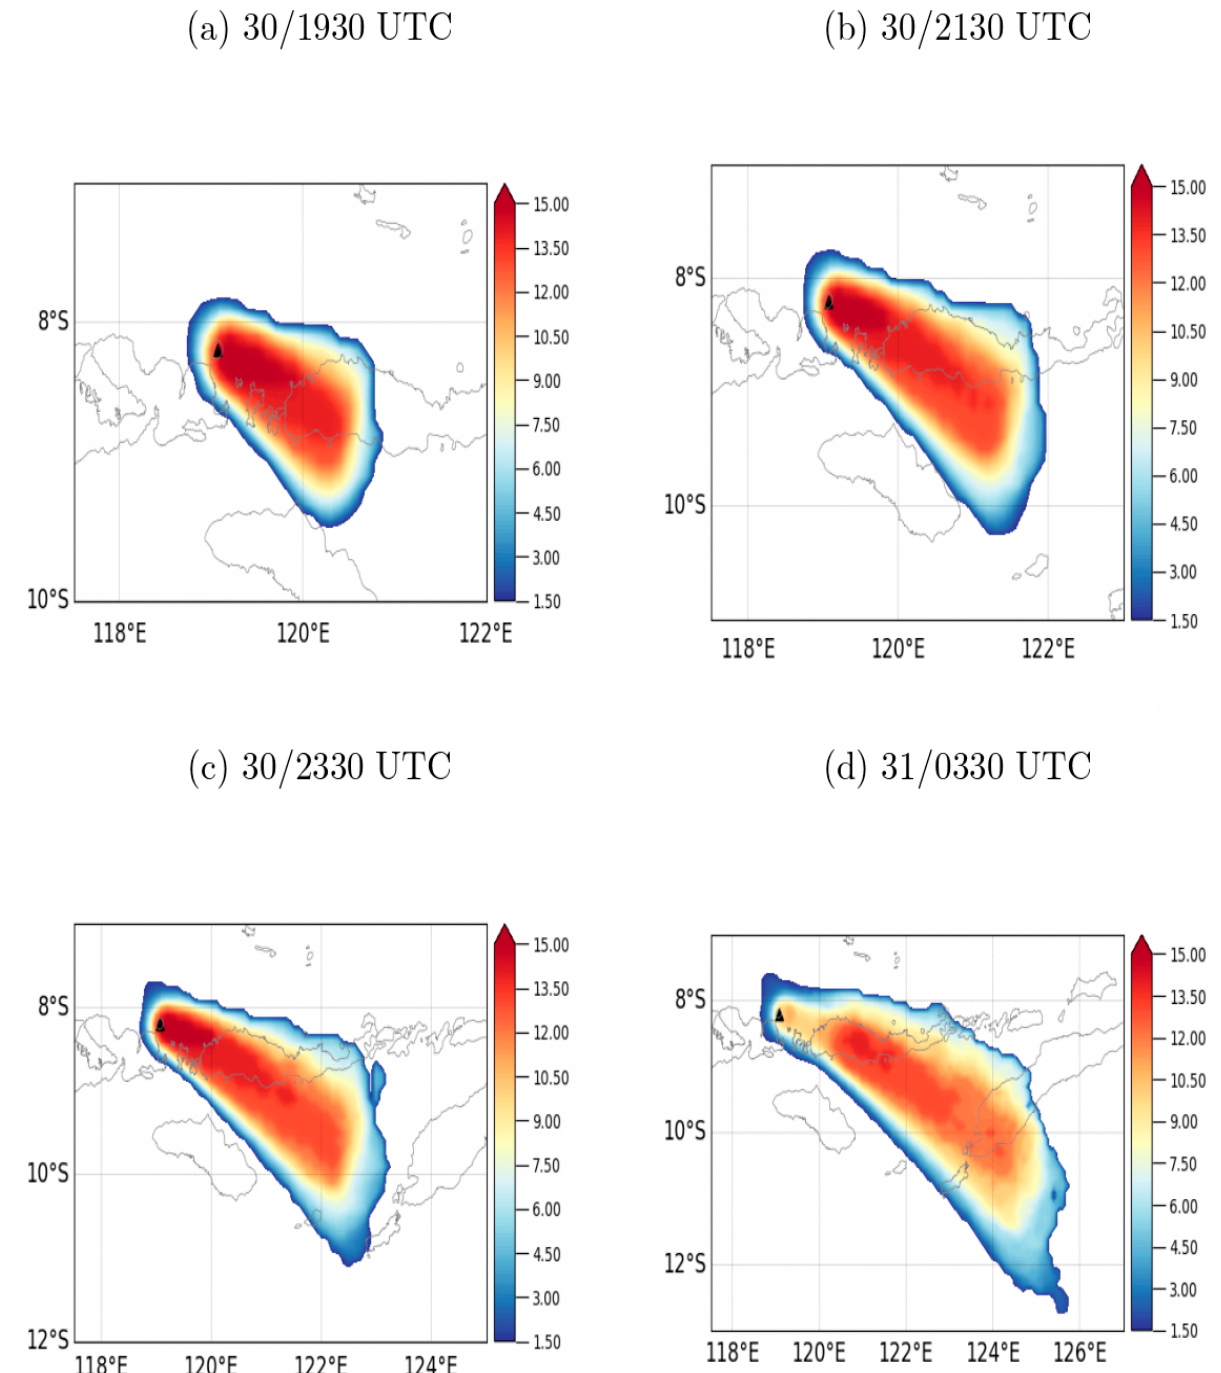
Figure 5. Ensemble mean cloud top height fields (in km) obtained from the control experiment in this study utilizing a simple top hat function for the source time variation. The black triangle indicates the volcano location.